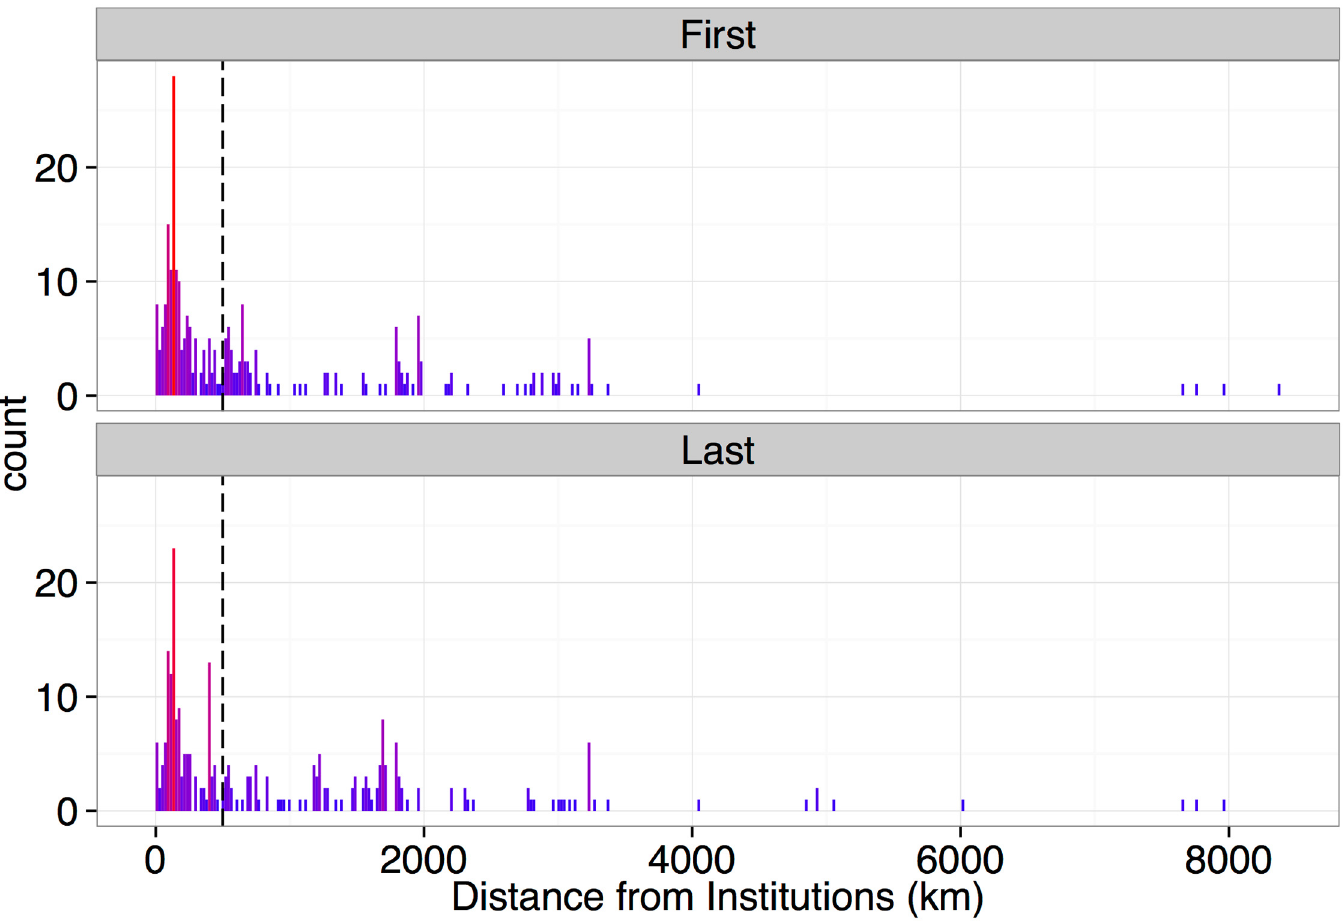
Fig 5. Distances (km) between locations of studies and locations of the first and last authors. The long dashed line shows the locations of studies conducted at 500-km distances from the authors ’ affiliations. Red bars represent a high frequency of counts of distances from the institutions.